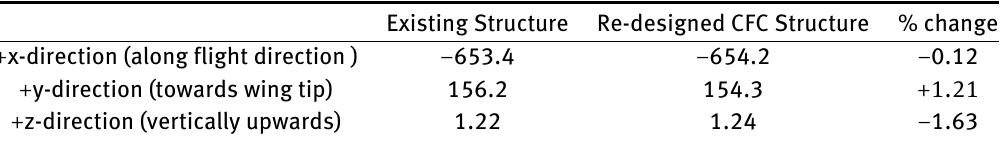
Table 4: CG shift [Reference is point-1 of Fig. 8(a)]